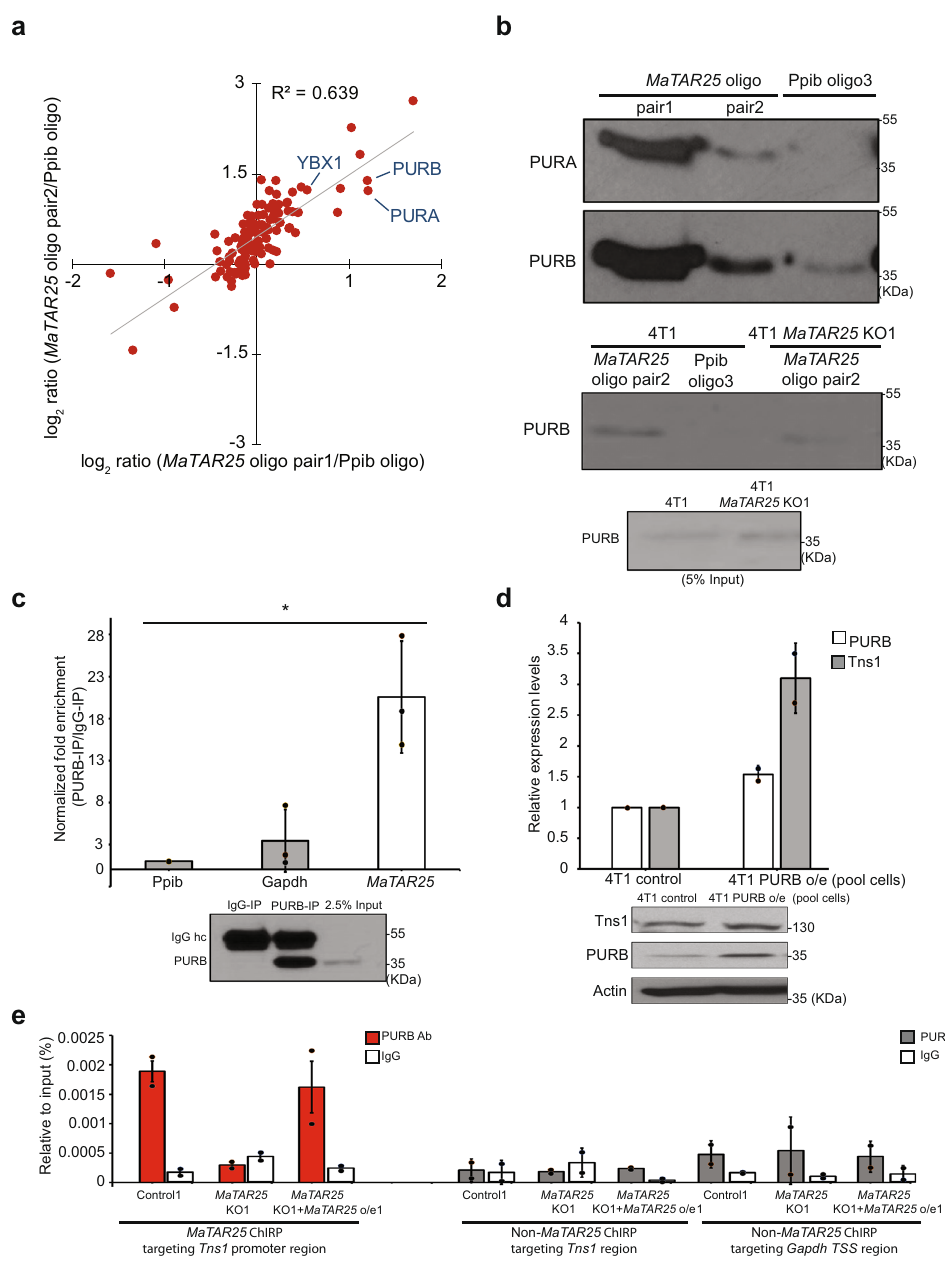
Fig. 5 MaTAR25 interacts with PURB to carry out its function. a Scatterplot depicts the fold enrichment of protein candidates from isobaric tags for